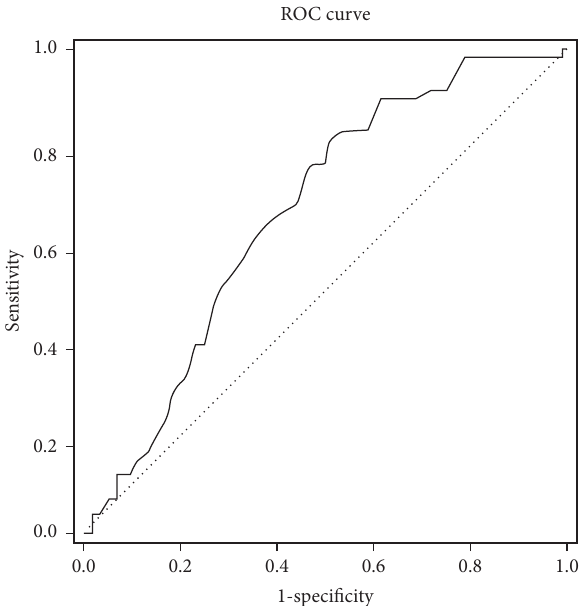
Figure 4: ROC analysis chart for age according to VAS success. For age 44 cutting value, sensitivity 81.36%, specificity 49.04%, the positive predictive value is 47.52, and the negative predictive value is